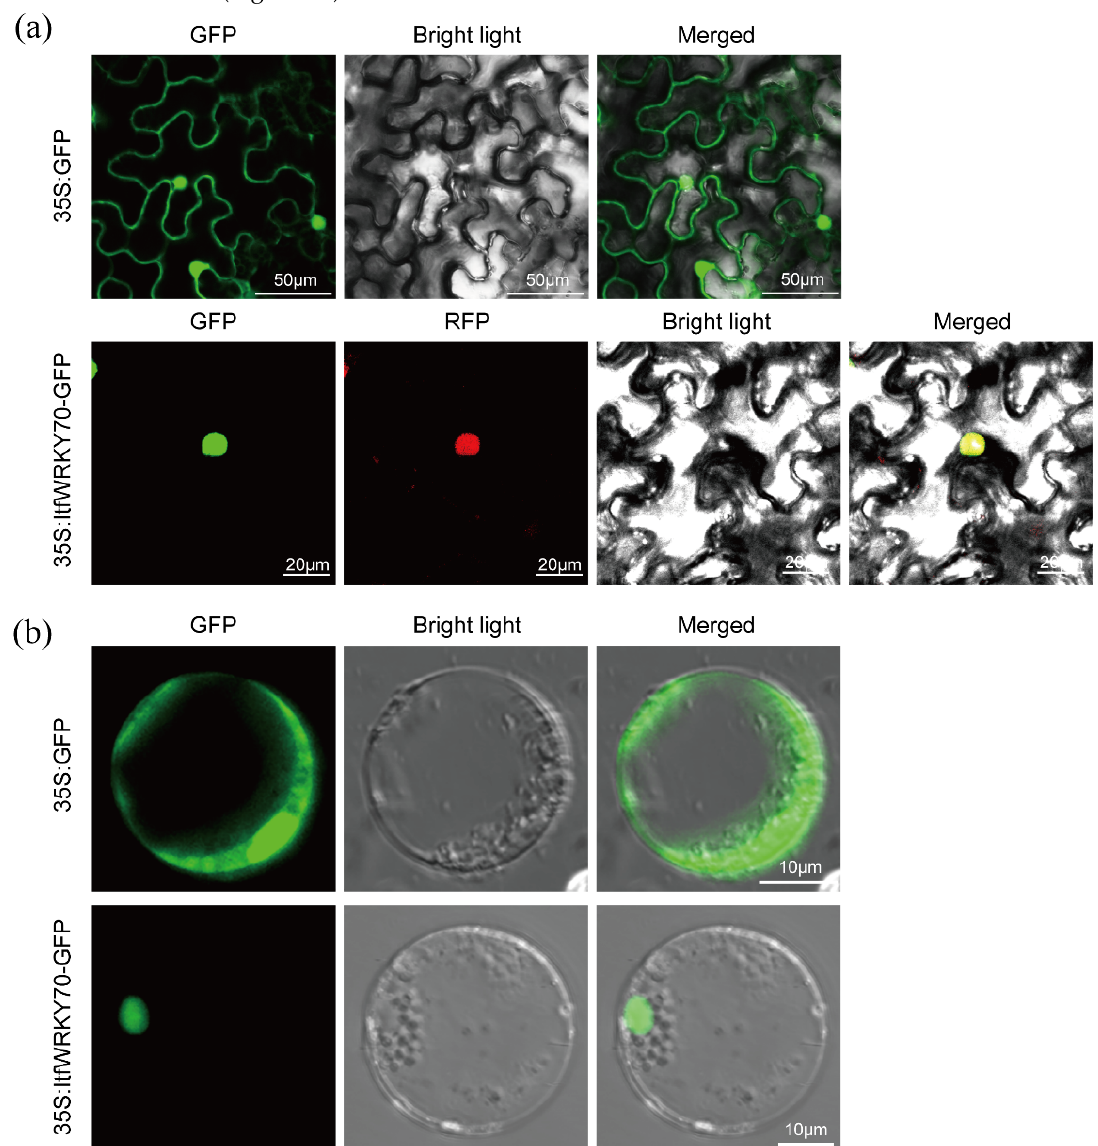
Figure 3. Subcellular localization of ItfWRKY70 in tobacco leaf epidermal cells ( a ) and rice protoplasts ( b ). Confocal scanning microscopic images showed that the ItfWRKY70-GFP fusion protein localized in nuclei vs. GFP as the control.